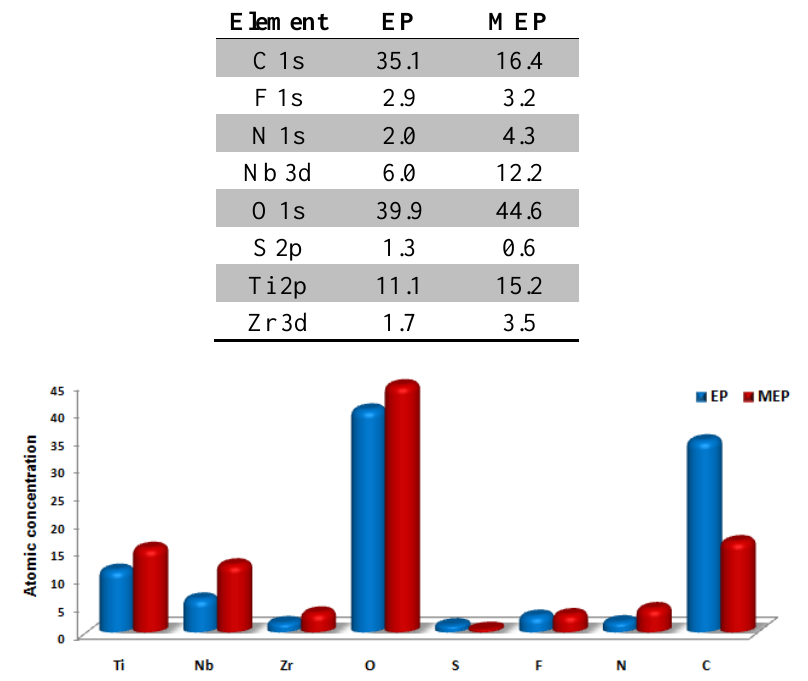
Figure 6. Atomic concentration diagram of the TNZ passive layer alloy after EP and